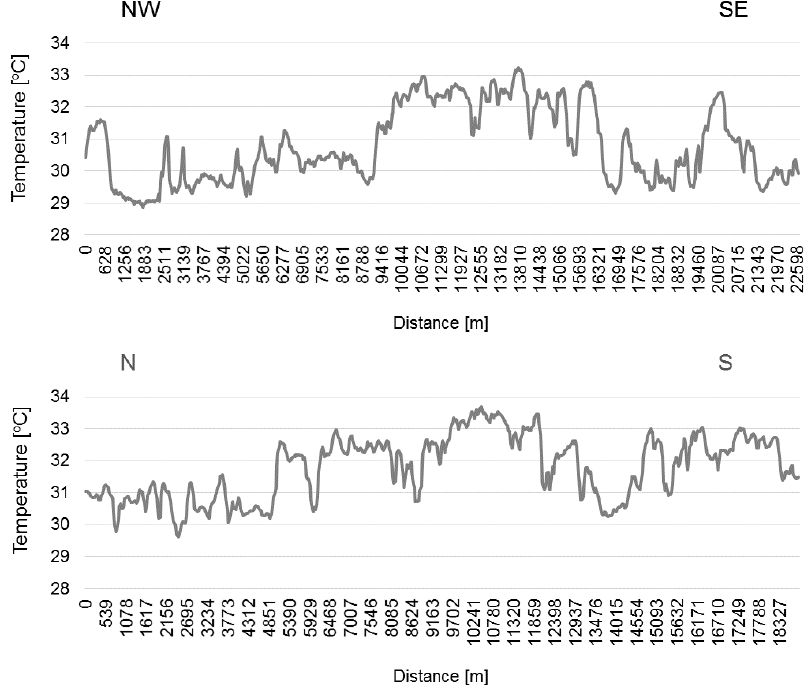
Figure 9. Air temperature in NW–SE and N–S profiles on 12 July 2010 at 9:43 UTC.